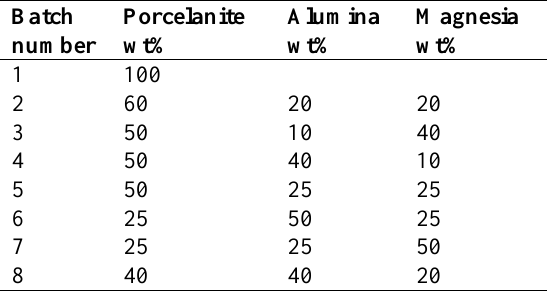
Mixing ratios in weight percentages of starting materials to prepare Porcelanite based refractory.